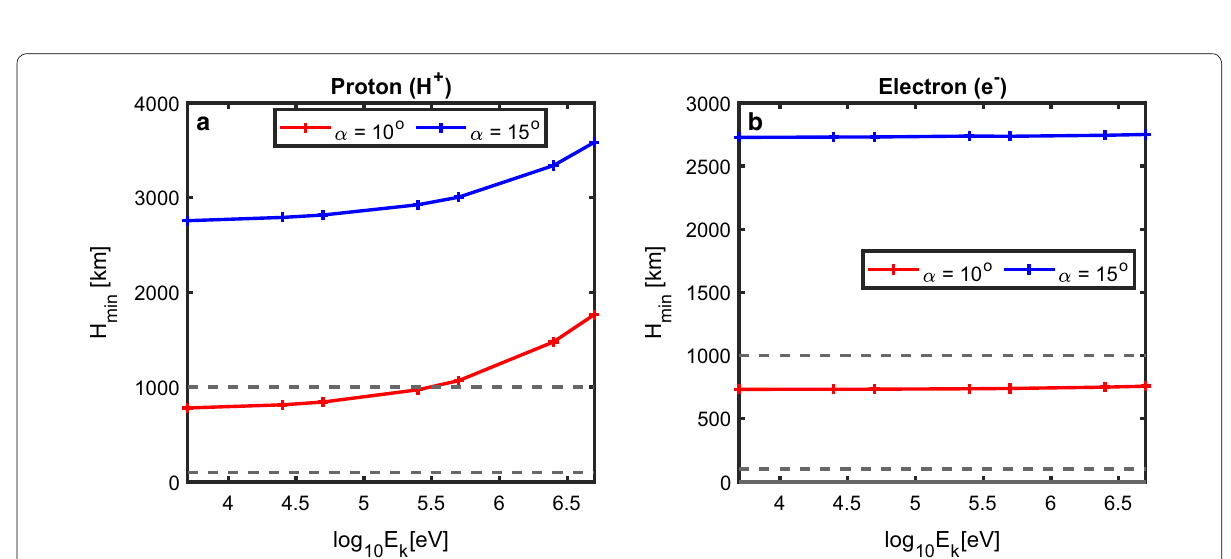
Fig. 9 The minimum vertical height of a protons and b electrons above the surface of the Earth as a function of the energy at L = 3 with the equatorial pitch angle of 10 ◦ and 15 ◦ . The horizontal dashed lines correspond to the ionospheric boundaries at 1000 km and 100 km, respectively, above the surface of the